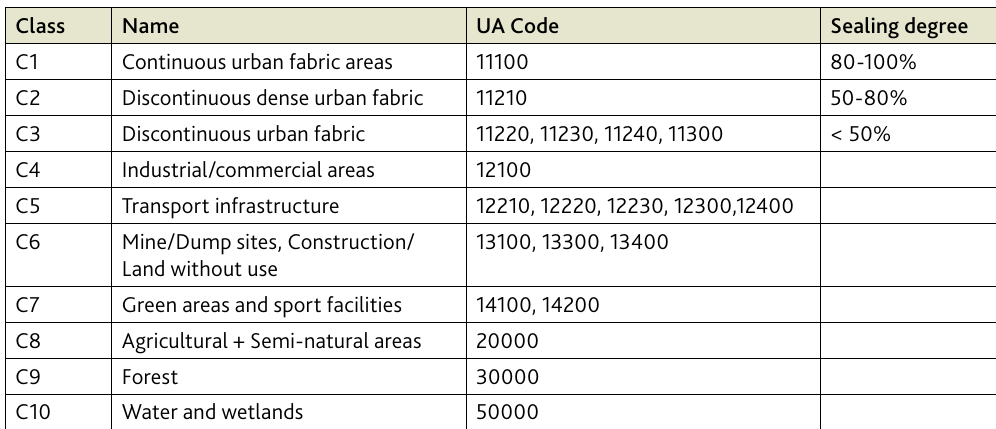
Table 2. Land use UA